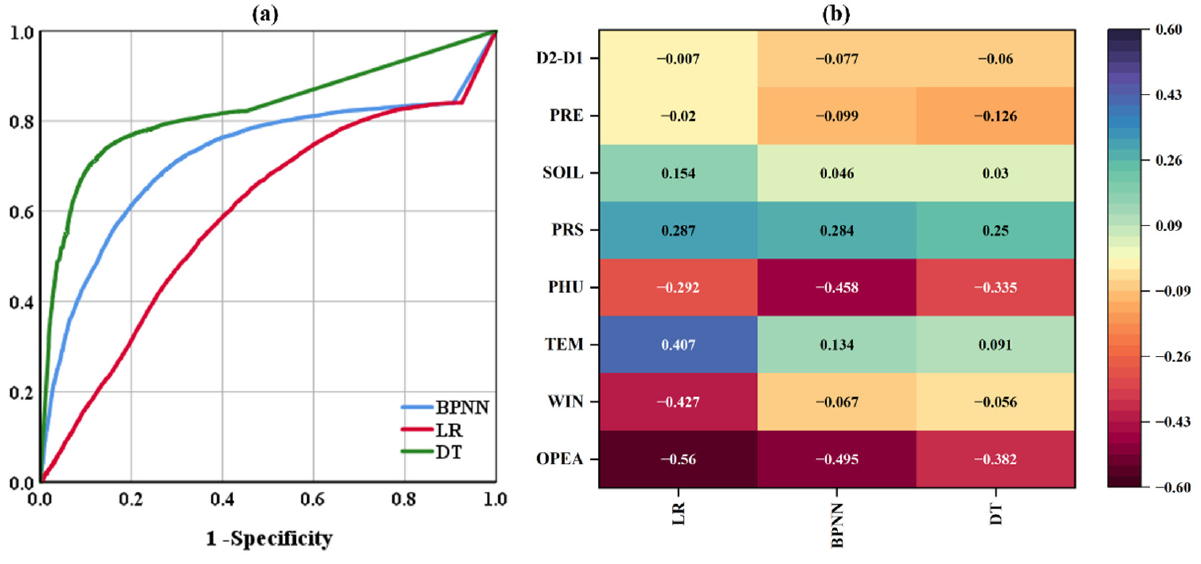
Figure 4. ROC curves ( a ) and heatmap of impact factor correlations ( b ) for LR, BPNN, and DT models in this study. Table 3. Results of verification accuracy and fit superiority of LR, BPNN, and DT models for all variables across Northeastern China in